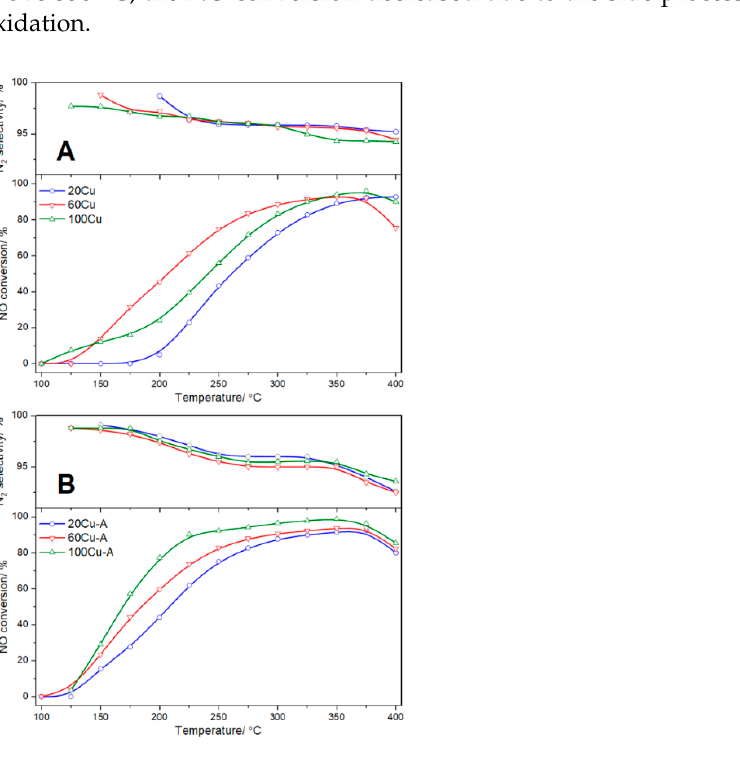
Figure 10. Temperature dependence of the NO conversion and N 2 selectivity in NH 3 -SCR for the Al-S-MCM-41 sample modified with copper by TIE ( A ) and TIE-NH 3 ( B ) methods.